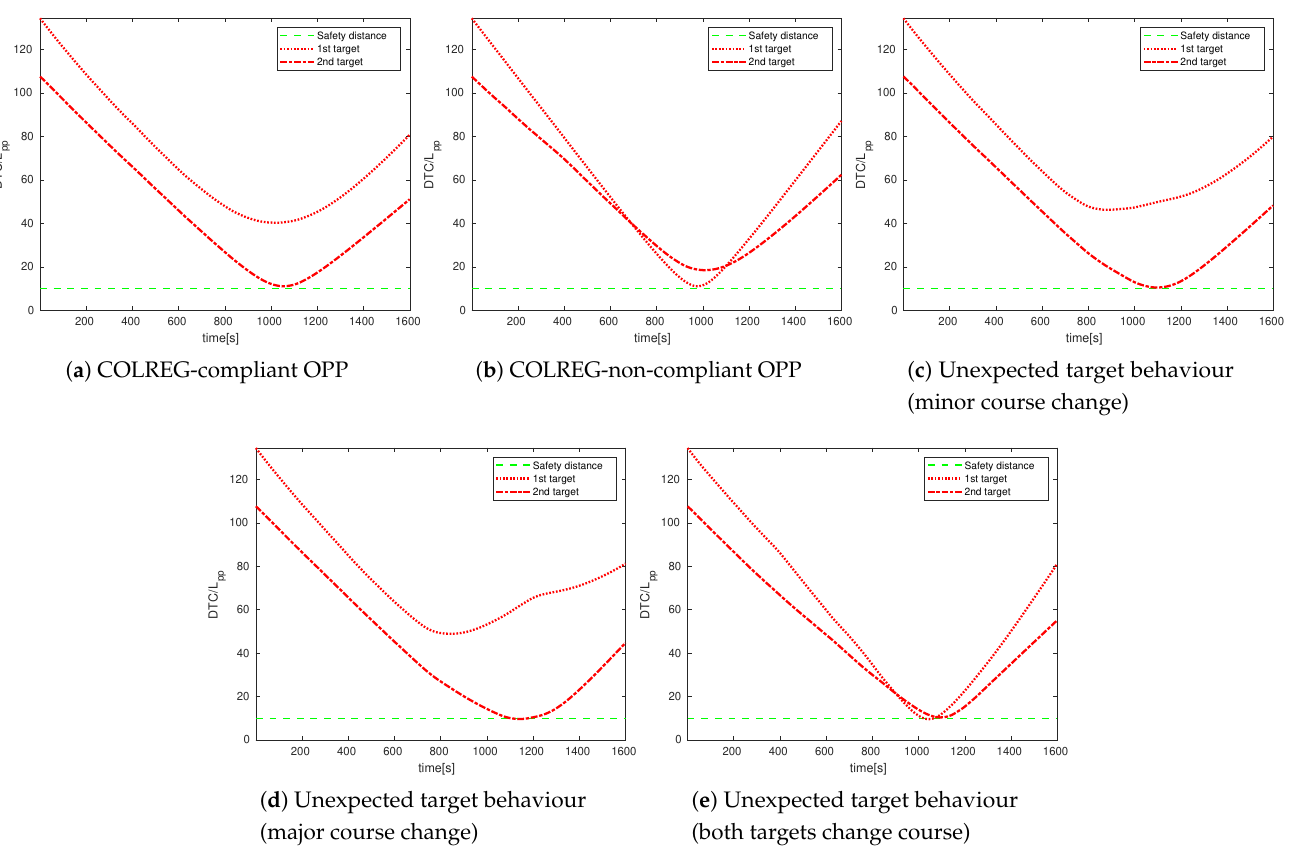
Figure 16. Scenario 2: DTC during simulation of a COLREG-compliant manoeuvre ( a ), COLREG-non-compliant manoeuvre ( b ) and COLREG-compliant manoeuvre with unexpected target behaviour ( c – e